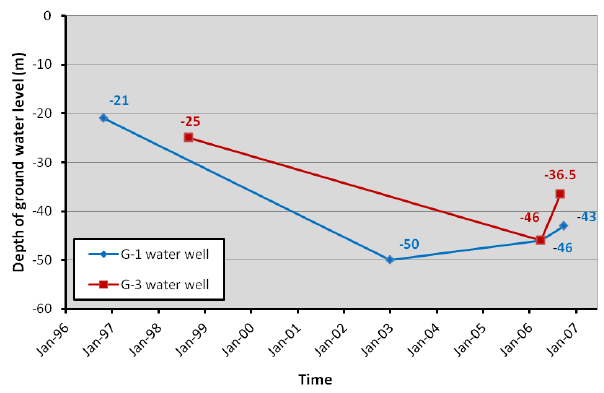
Fig. 12. Fluctuation of ground water table in G-1 and G-3 wells. Figure 12. Fluctuation of ground water table in G-1 and G-3 wells. Redrawn from 855 Redrawn from Koumantakis et al. Koumantakis et al. (2008). 856